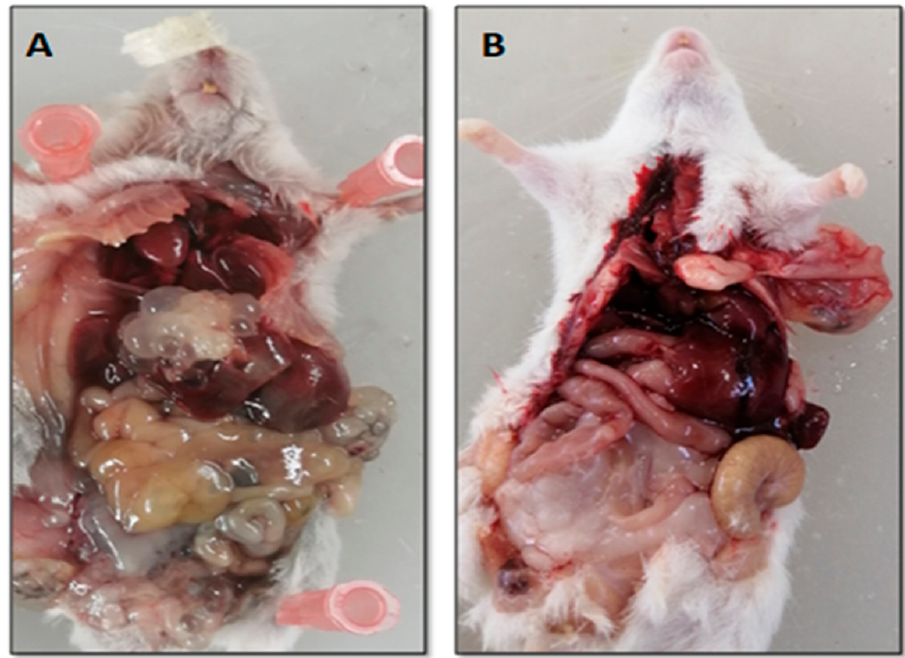
Figure 5. Heavily infected liver with secondary hydatid cyst after six months post-infection ( A ), compared with liver of control non-infected mice ( B ).